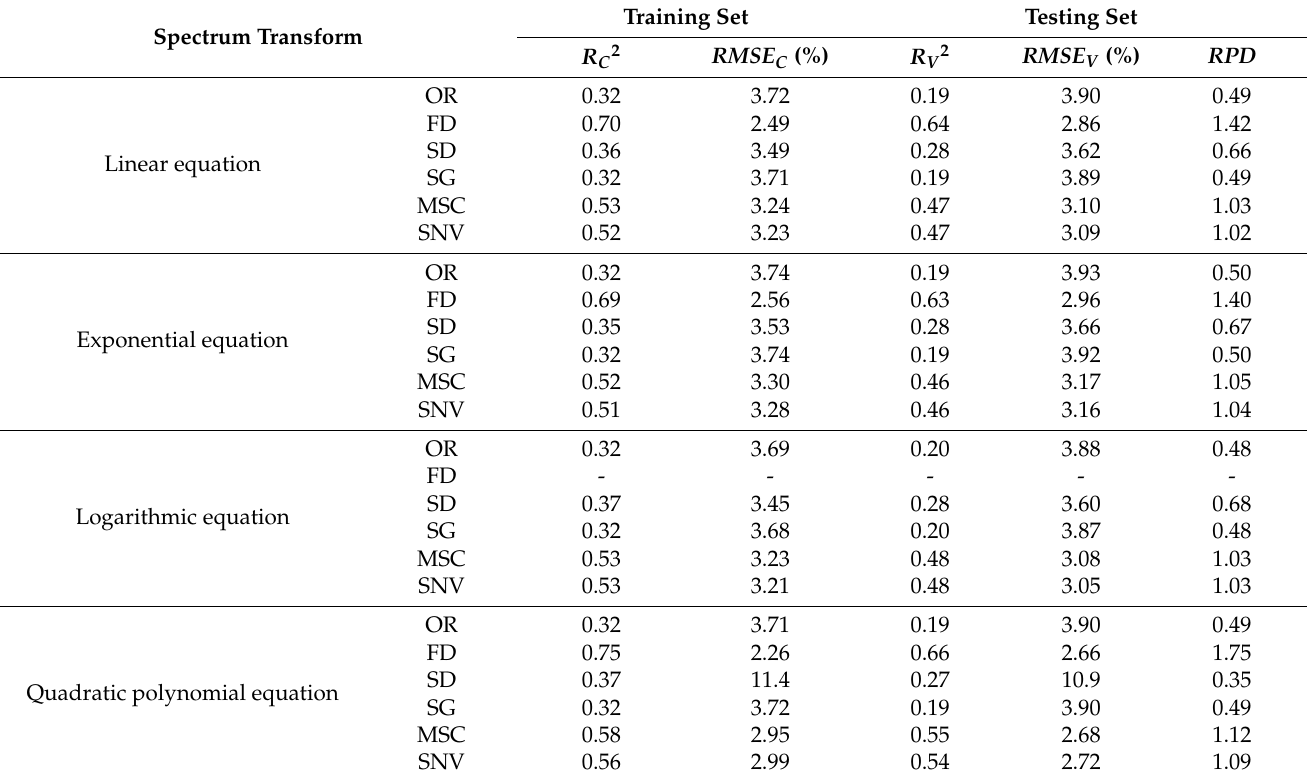
Table 3. Performance of the Fv/Fm univariate model in the training and testing